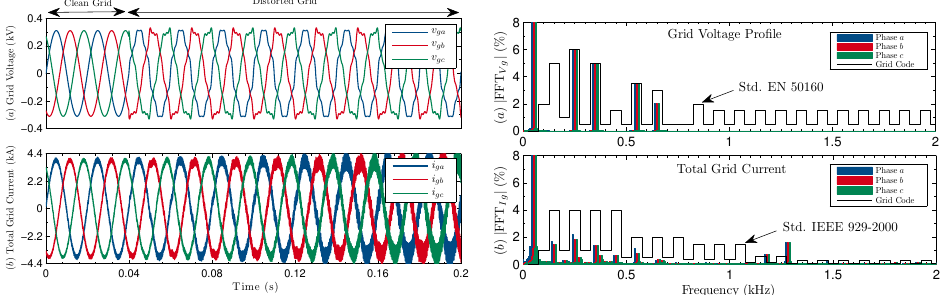
Figure 16. Simulation results of bus 2 with parameters of Feeder 1, time ( left ) and harmonic ( right ) responses. ( a ) grid voltage and its harmonic response; ( b ) Norton model and its harmonic response.